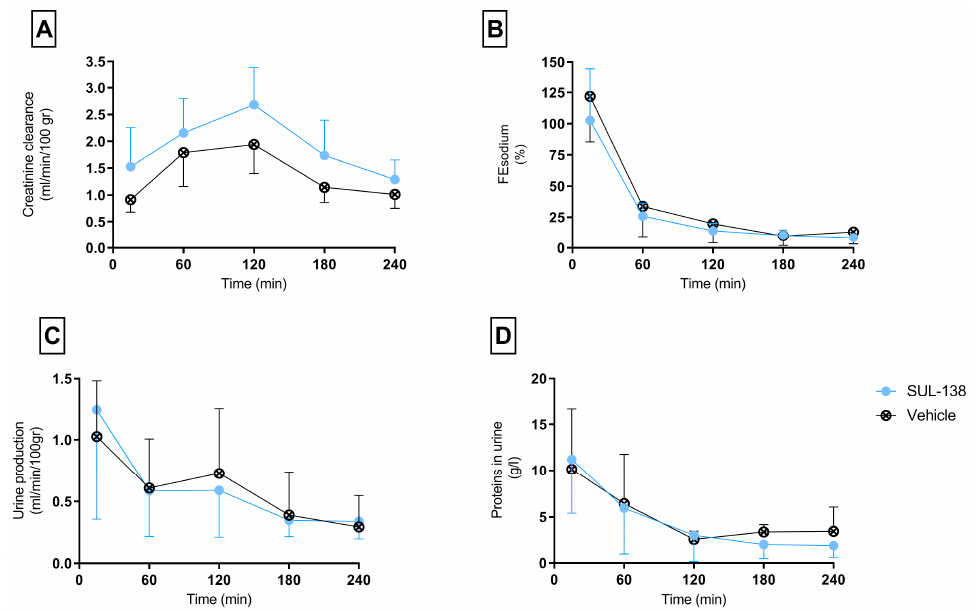
Figure 2. Kidney functionality parameters during normothermic machine perfusion. Porcine kidneys were tested for kidney function for 4 h with NMP after 24 h HMP with (SUL—138 • ) and without (Vehicle ⊗ ) SUL—138. ( A ) Creatinine clearance rates, ( B ) Fractional sodium excretion, ( C ) Urine production, ( D ) Protein content in urine. NMP, normothermic machine perfusion; HMP, hypothermic machine perfusion. The data are shown as mean ± SD.